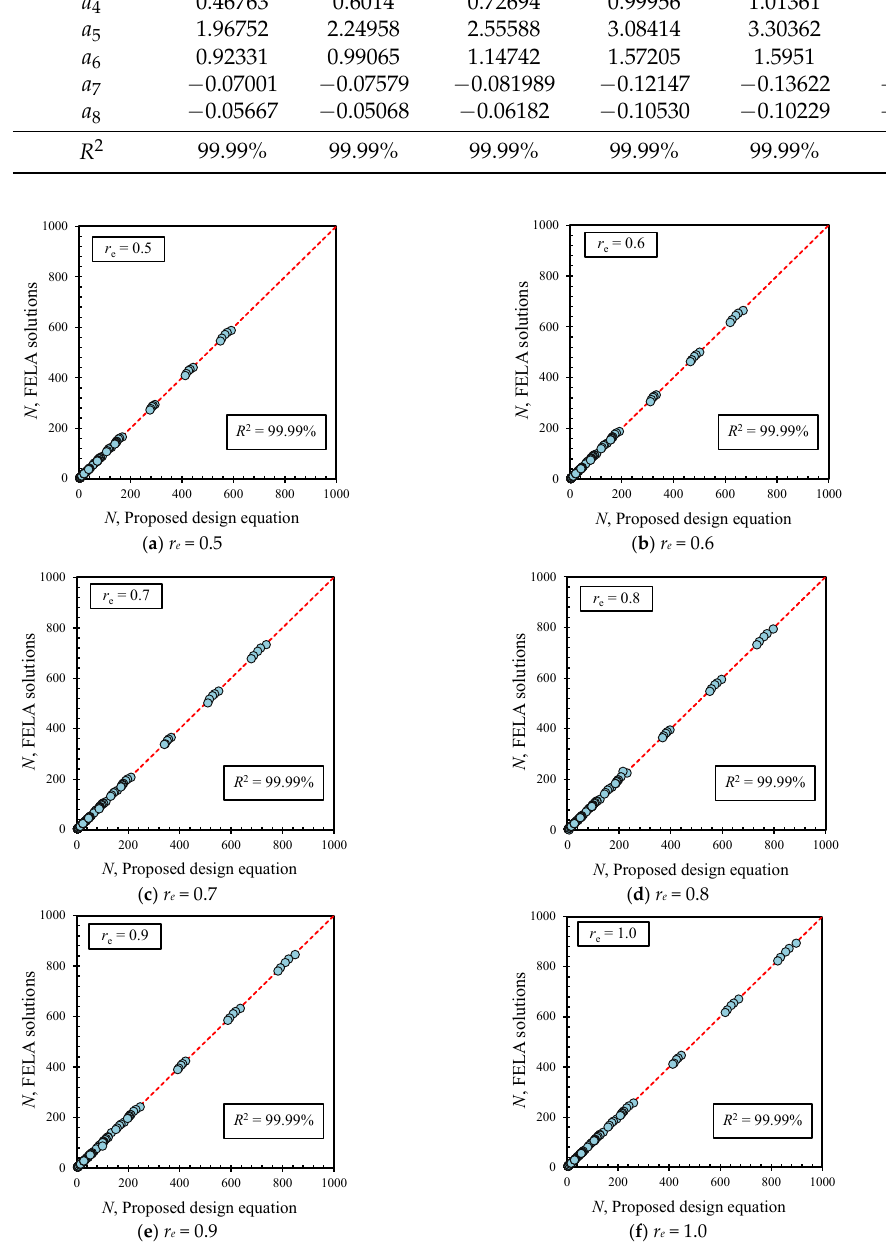
Figure 14. Predicted N vs. FELA N.